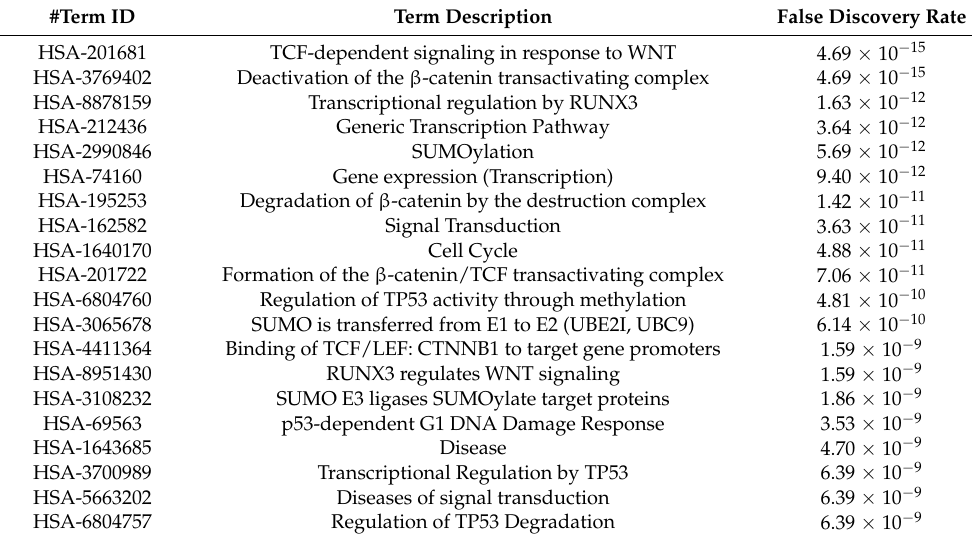
Table 2. Reactome pathway analysis of individual functional protein partners correlated with the three SOX